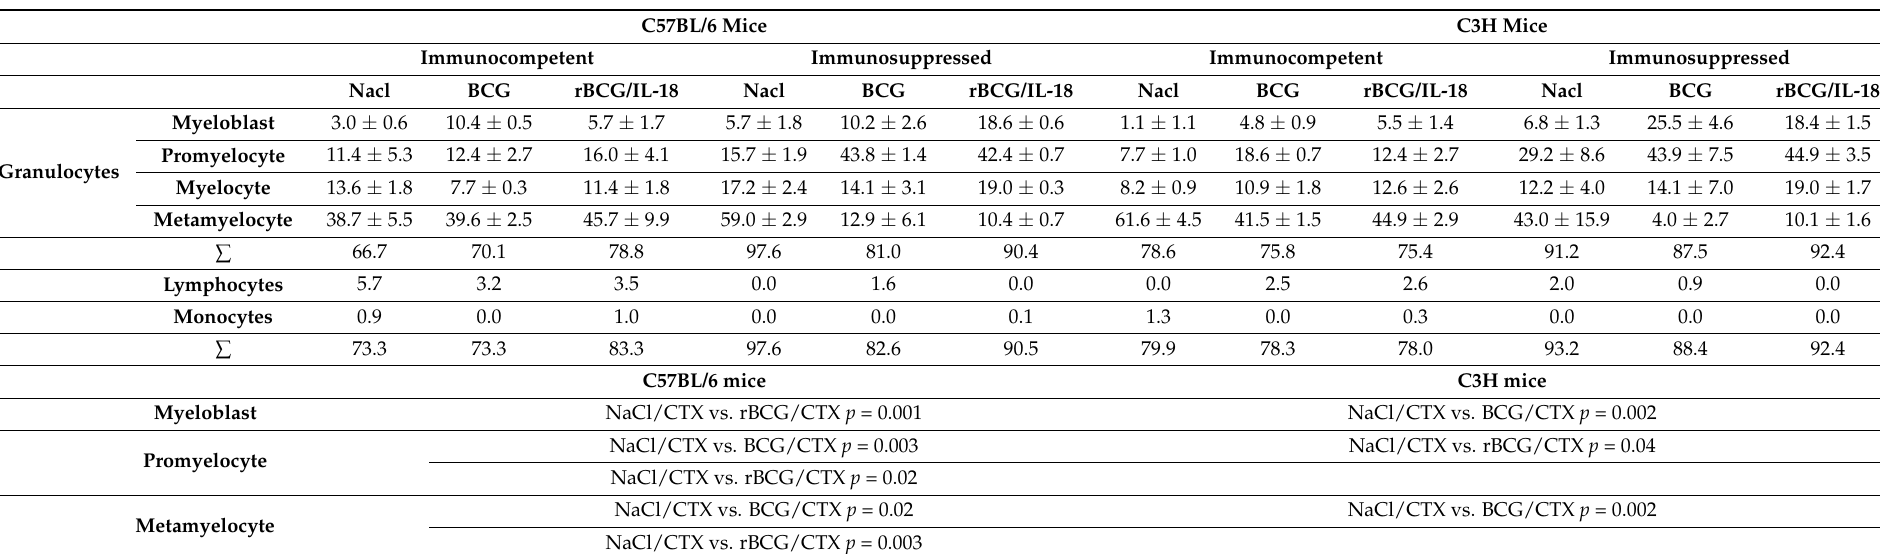
Table 1. Leukocyte composition (%) of bone morrow cells isolated from C57/BL6 and C3H mice who had been immunized with the wild-type BCG or recombinant BCG secreting IL-18 (rBCG/IL-18) strains and from immunocompetent or cyclophosphamide (CTX) immunosuppressed animals. Data are shown as mean ± SEM (standard error of the